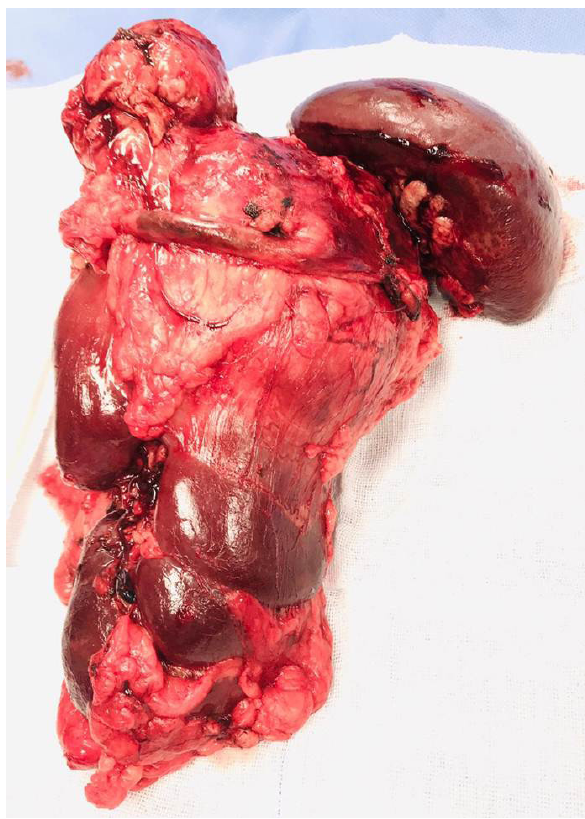
Figure 2: The resected en bloc mass showing the kidney, spleen, and tail of